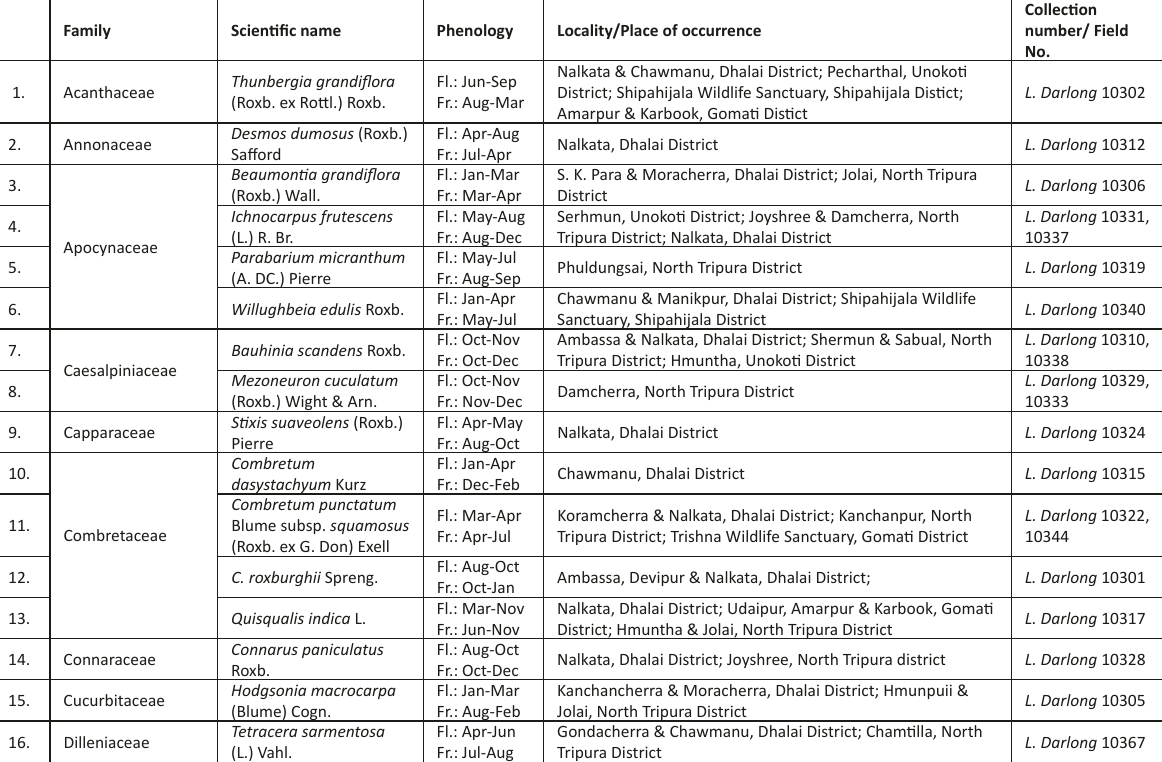
Table 1. Enumeration of species of lianas in Tripura with their phenology, collection sites and collection/field